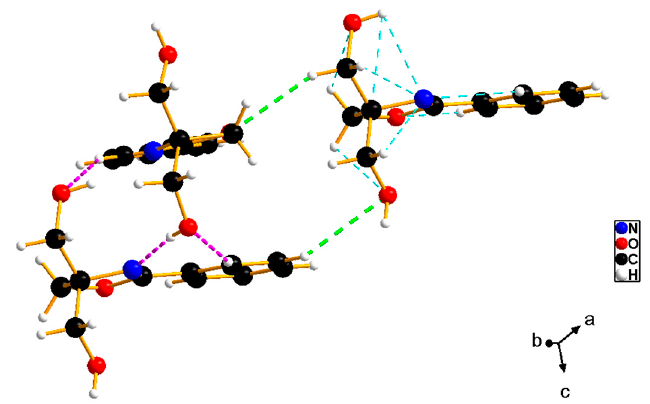
Figure Figure 3. Portion of the 3D structure of compound 2 showing the intra- (cyan), and inter-connections H- Bonds (Pink, between two neighbouring molecules “dimers” and green between two neighbouring “dimers”.